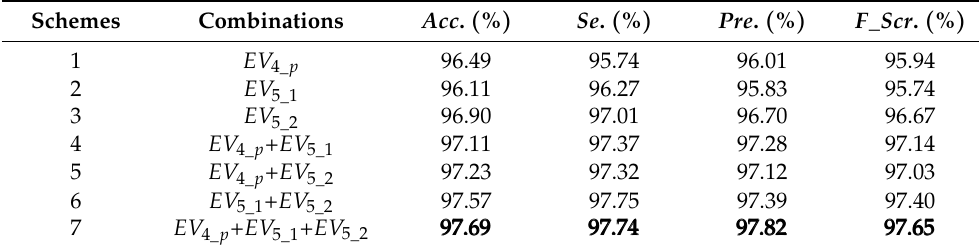
Table 4. Classification accuracies on fusing the three best